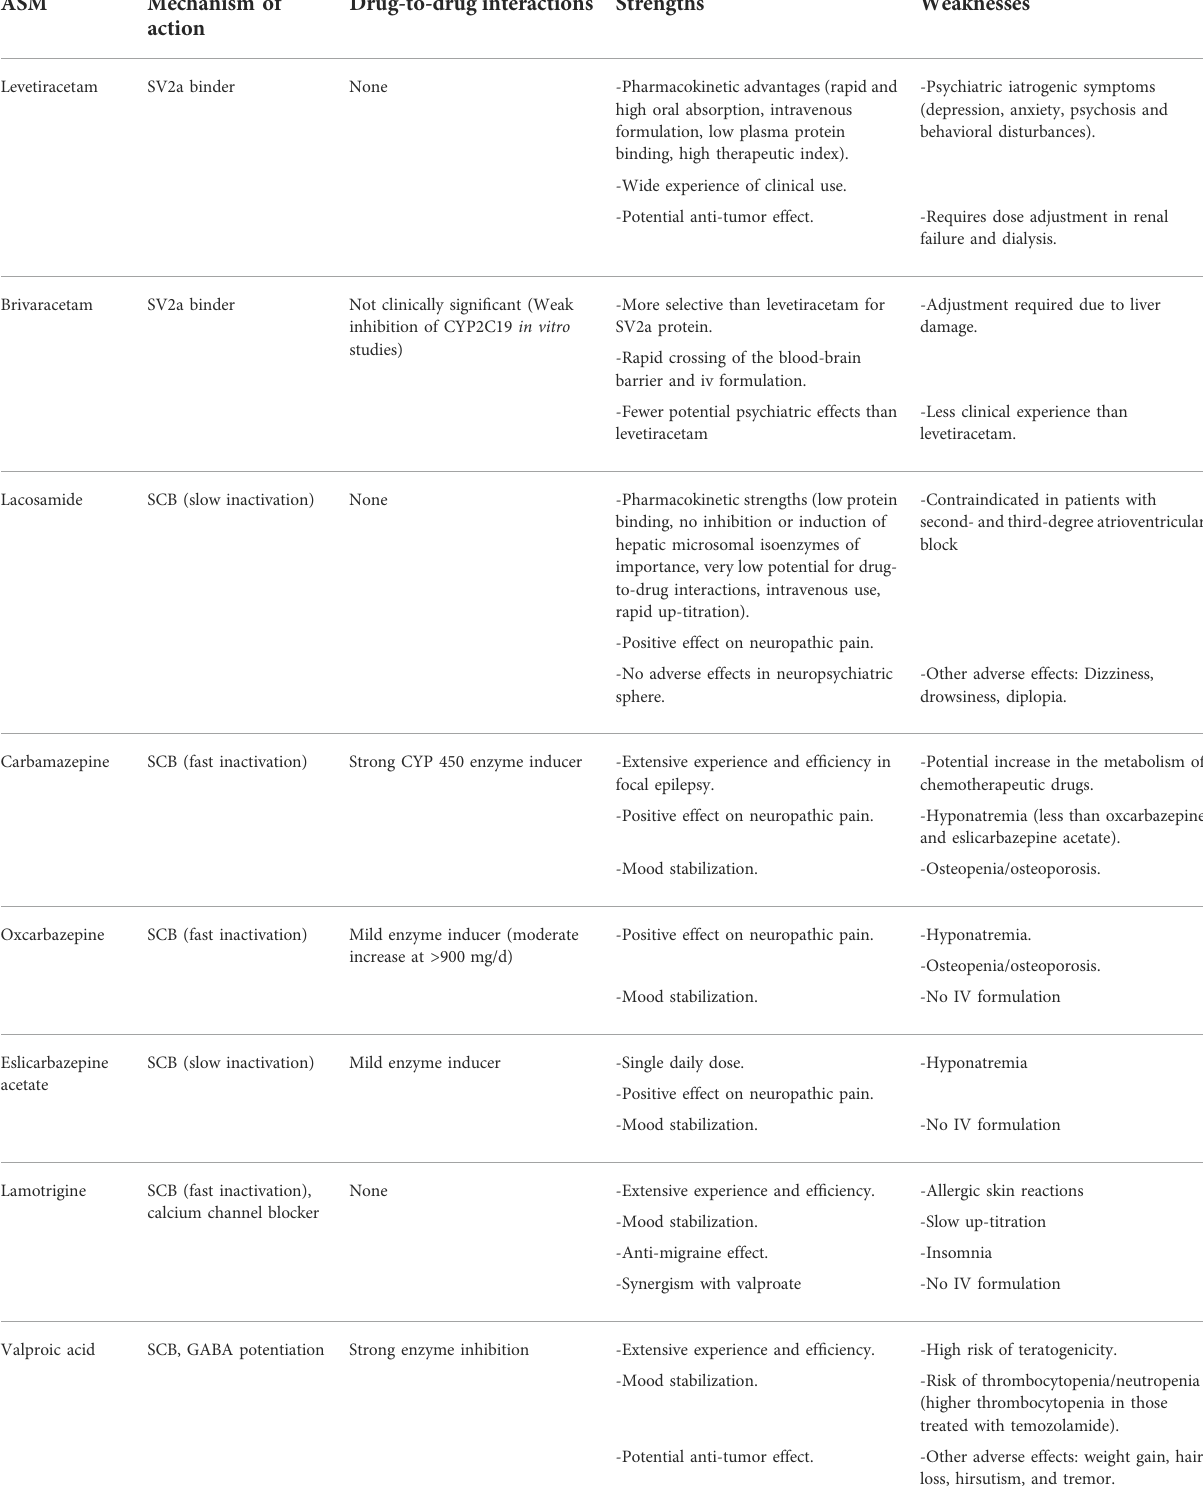
TABLE 2 Commonly used antiseizure medications in patients with brain tumor related